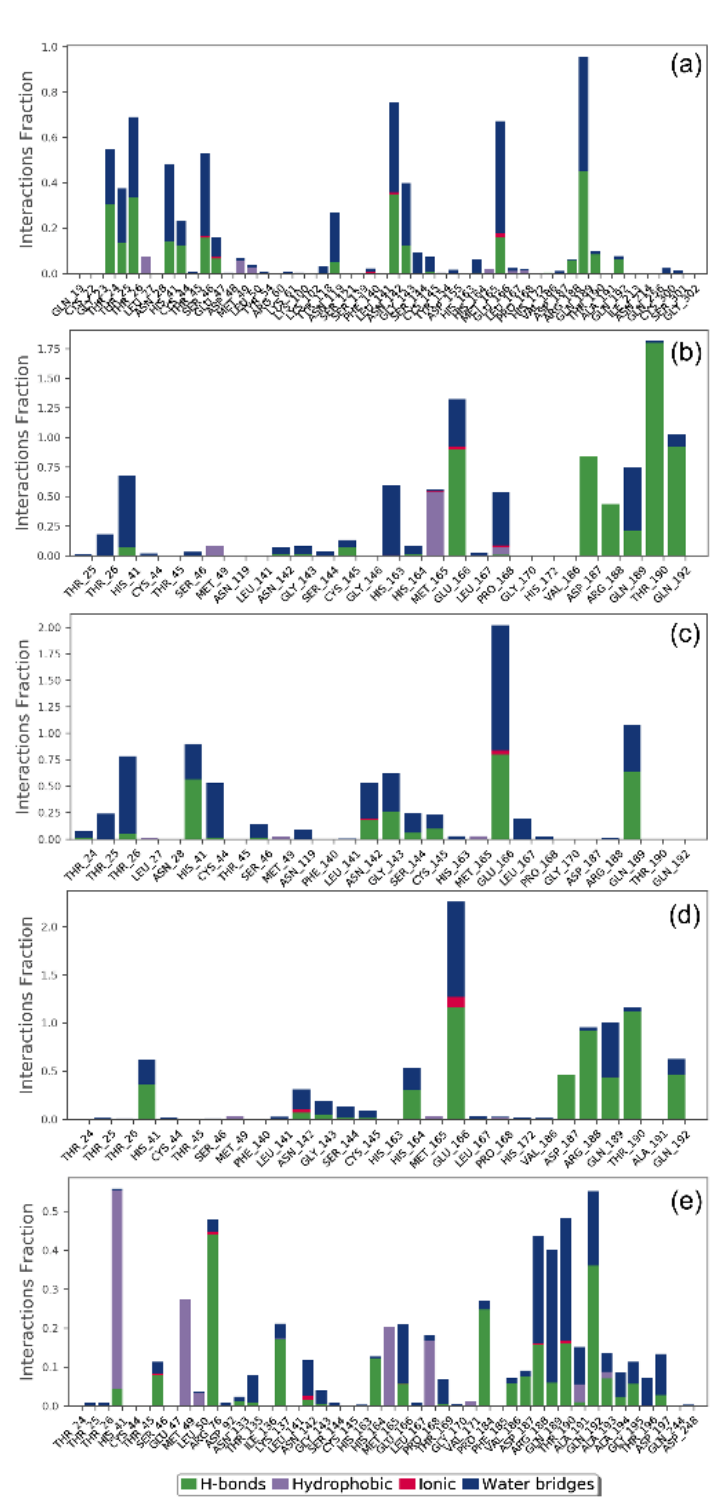
Figure 7. Protein-ligand interactions contact profiling for SARS-CoV-2 M pro docked with potential natural products, viz. ( a ) Echinacoside, ( b ) Quercetagetin 7-glucoside, ( c ) Levan N, ( d ) Inulin from chicory, and ( e ) 1,3-Dicaffeoylquinica acid, computed from 100 ns MD simulation